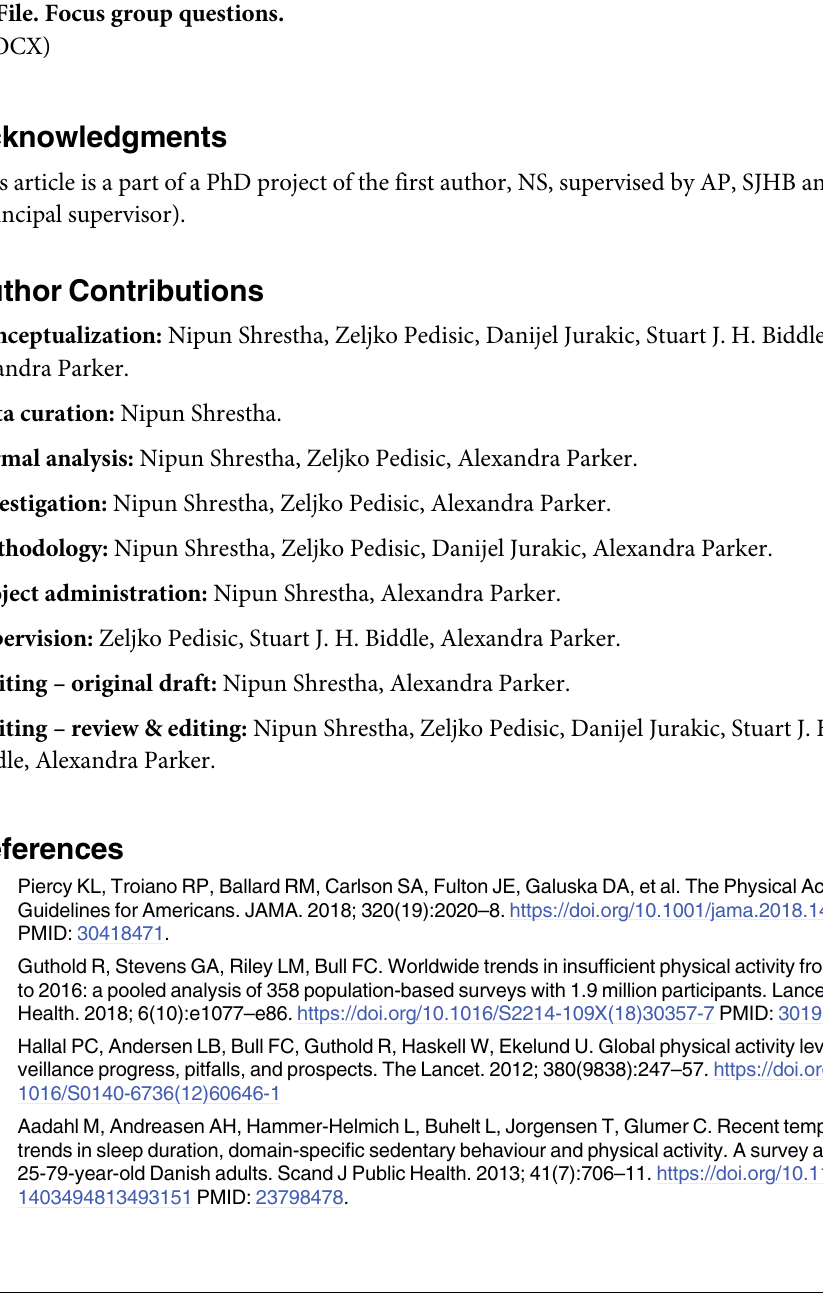
S1 Table. Mental health professionals’ perceived importance of different types of treat- ment for people with mental illness. S2 Table. Mental health professionals’ specific practices in recommending physical activ-